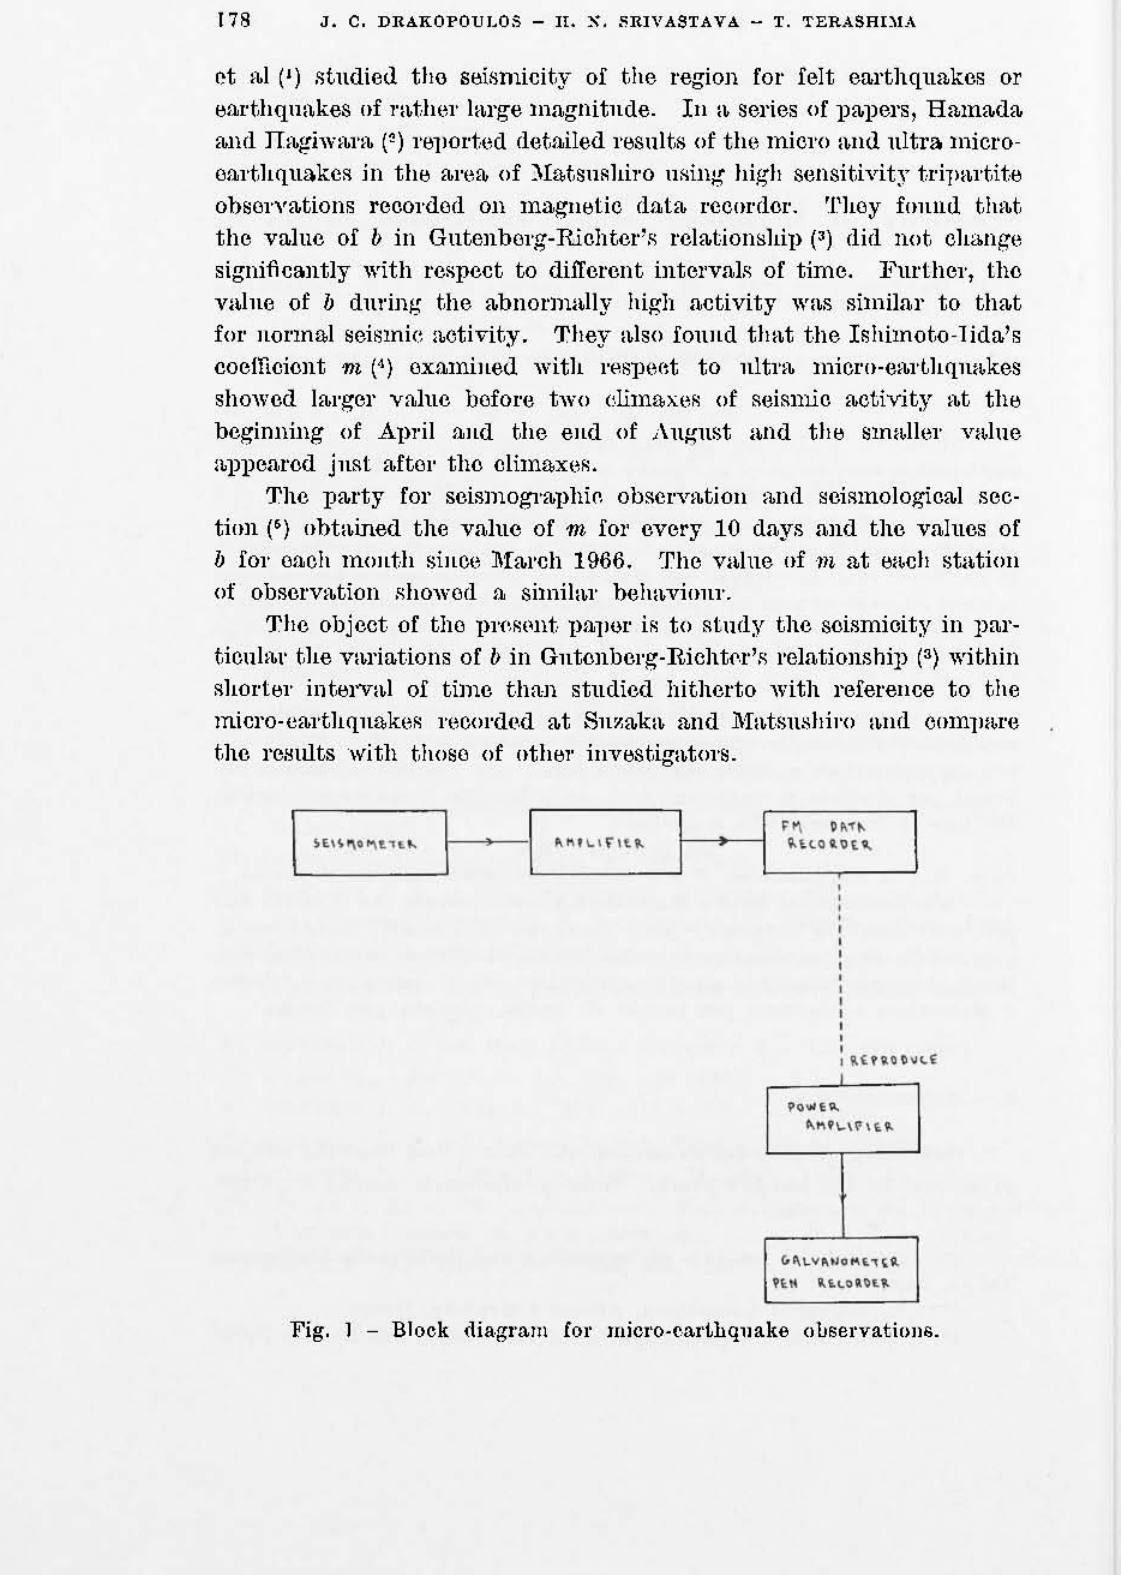
Fig. l - Block dia.gram for micro-carthqllake